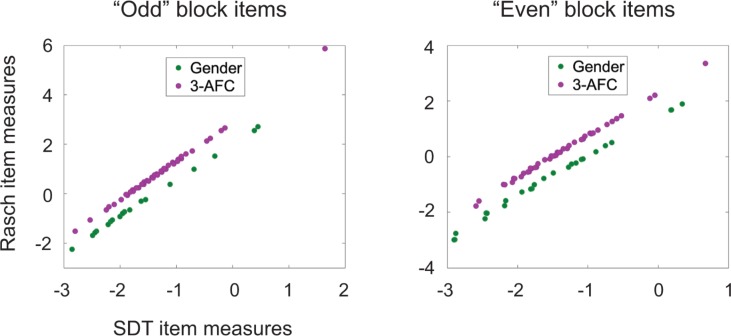
SDT vs. Rasch.Estimated item measures are shown for SDT in d prime units and for the dichotomous Rasch model in logits with "odd" block items (blocks 1, 3, 5 and 7) and "even" block items (blocks 2, 4, 6 and 8) plotted separately because different groups of persons responded to the two sets of items. For both groups the same relation holds: item measures are linearly related for any given m, but the intercepts of the best-fitting lines differ for different m. The slopes of the best-fitting lines for the 2-AFC task were nearly identical: 1.4782 for the "odd" items and 1.4737 for the "even" items; while the slopes differed for the 3-AFC tasks: 1.6064 for the "odd" and 1.5204 for the "even" items.